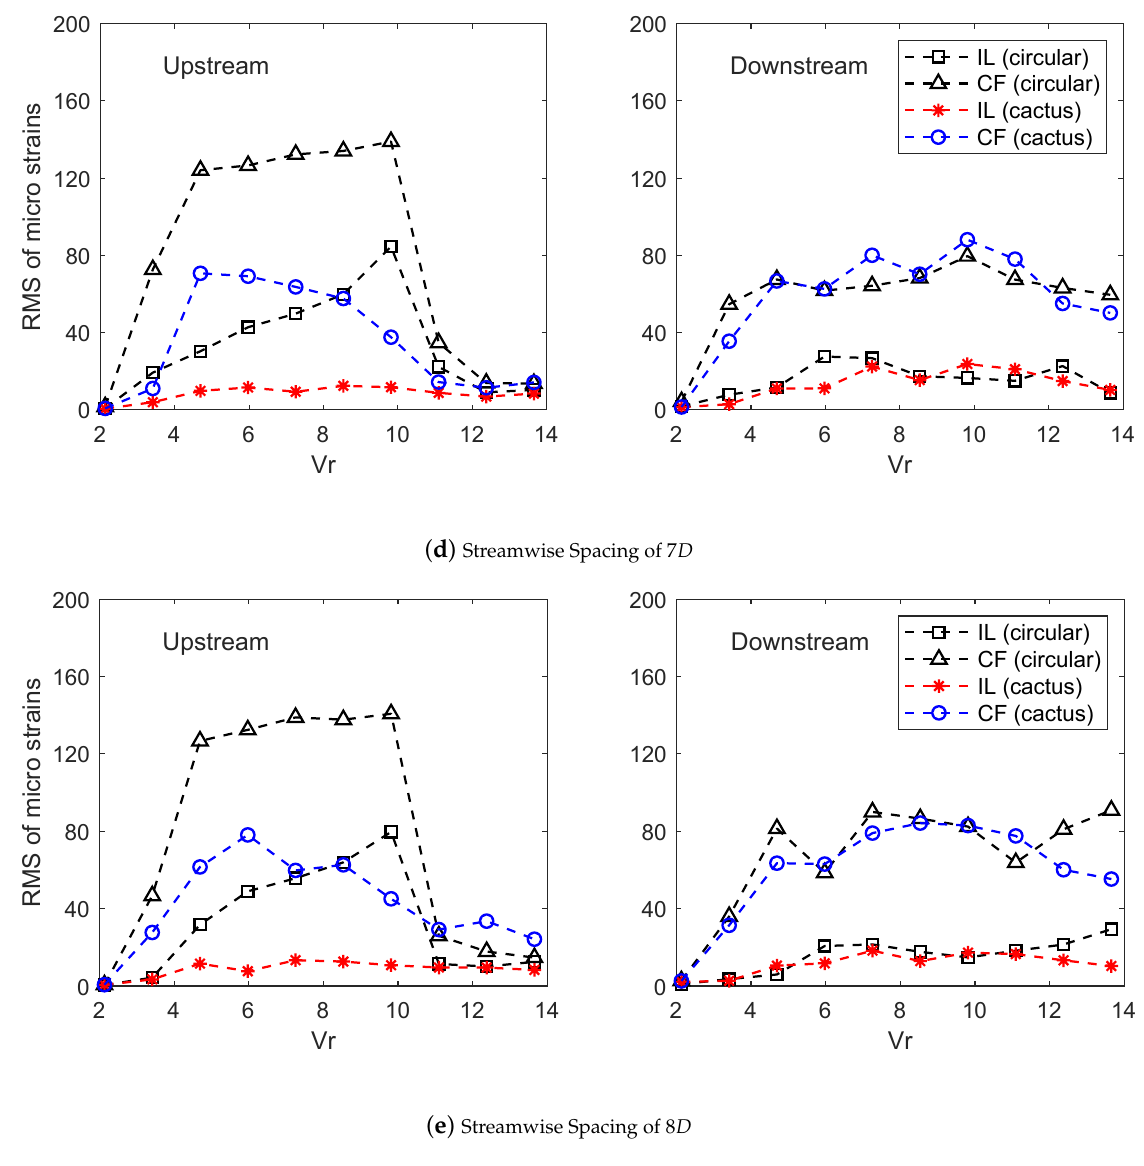
Figure 14. Comparison of dynamic responses measured on the two cactus-shaped and circular shaped flexible pipes: ( a ) Streamwise spacing of 4 D , ( b ) Streamwise spacing of 5 D , ( c ) Streamwise spacing of 6 D , ( d ) Streamwise spacing of 7 D , and ( e ) Streamwise spacing of 8 D